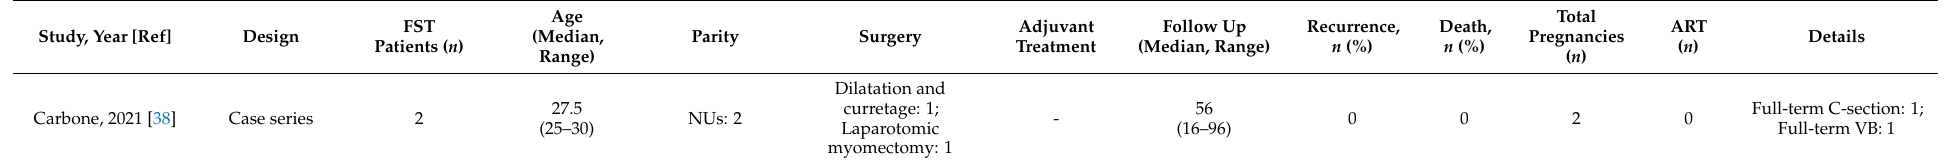
Table 6. Published reproductive and oncologic outcomes after FST of